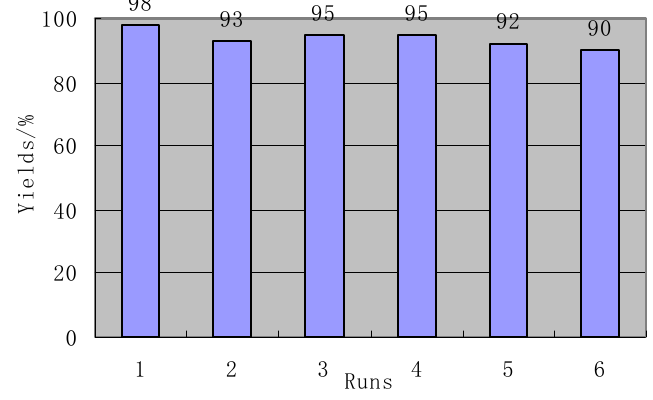
Figure 1. Reuse of ionic liquid for three components condensation of p -anisaldehyde (100 mmol), malononitrile and dimedone in the presence of ionic liquid [Ch]][OH] in aqueous